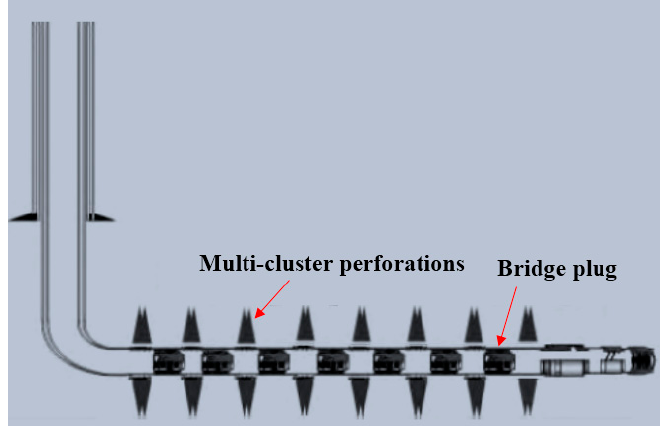
Figure 15. Schematic of the segmented multi-cluster fracturing technique with bridge plugs.